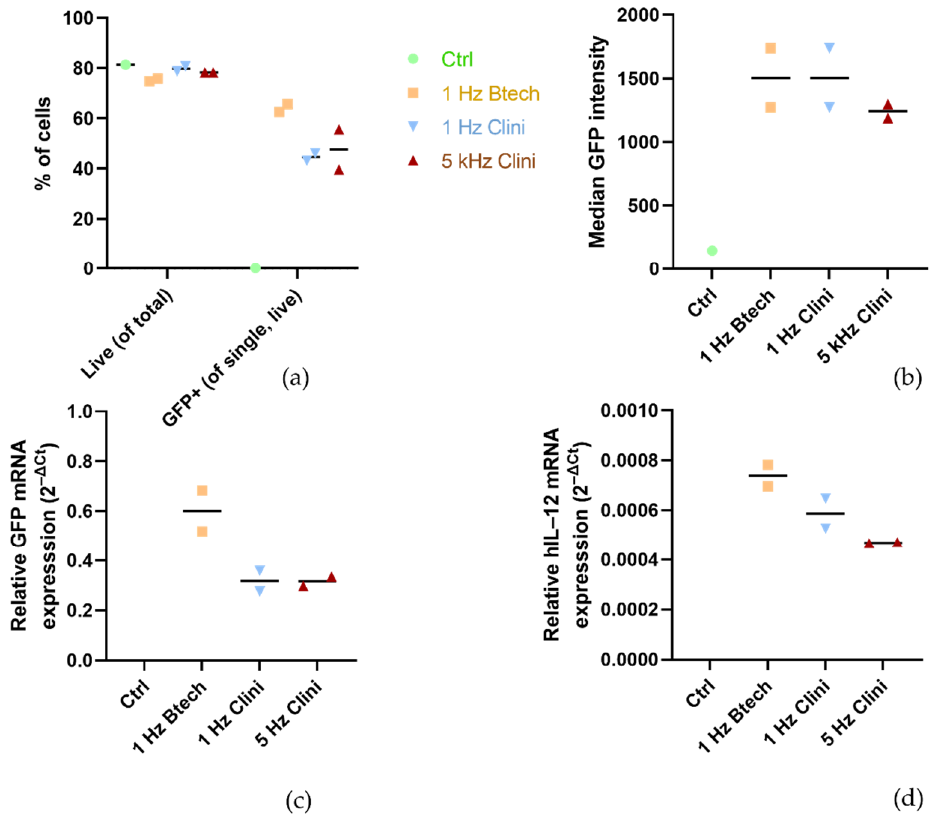
Figure 3. Efficacy of different electric pulse protocols. ( a ) Percentage of the live and GFP-positive cells; ( b ) median GFP intensity after GET of the pEGFP-N1 plasmid with different pulse protocols and devices. In all the three experimental groups (1 Hz Btech, 1 Hz Clini, 5 kHz Clini), eight 1300 V/cm pulses with 100 µ s duration were used; only the frequency (1 Hz or 5 kHz) and the device used (BetaTech or Cliniporator TM ) differed. The relative expression (normalized to β 2-microglobulin) of transgene ( c ) GFP or ( d ) hIL-12 after different pulse parameters and devices was also tested 2 days after GET with qRT-PCR, as described further in Section 2.6.1. “Total RNA Isolation and cDNA Reaction” and Section 2.6.3.